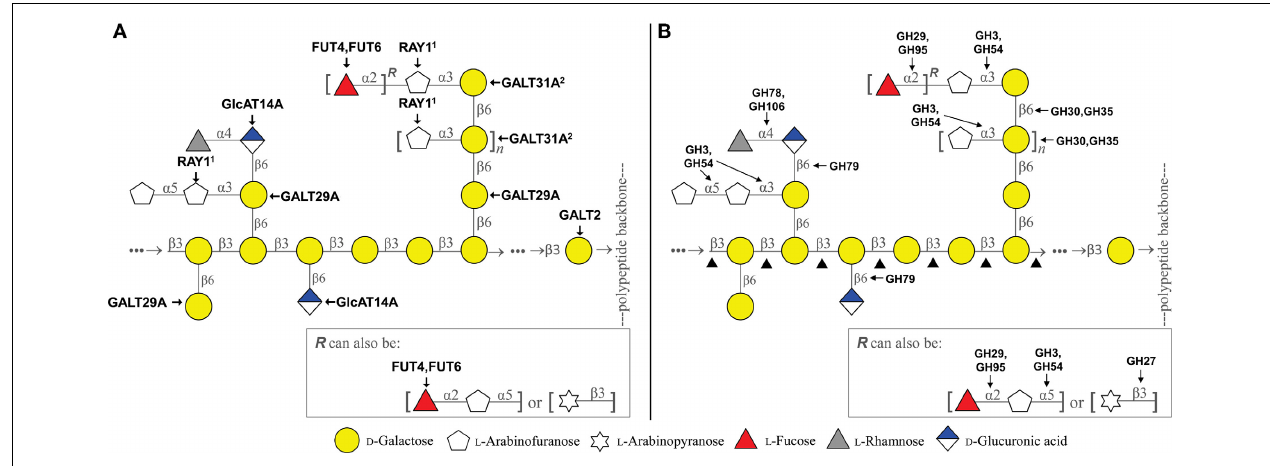
β -linked product (Gille et al., 2013). 2 Works cooperatively with AtGALT29A by forming a protein complex (Dilokpimol et al., 2014). (cid:2) includes GH16, GH35, GH43. The arabinogalactan model was modified from Tan et al. (2010) and Tryfona et al.